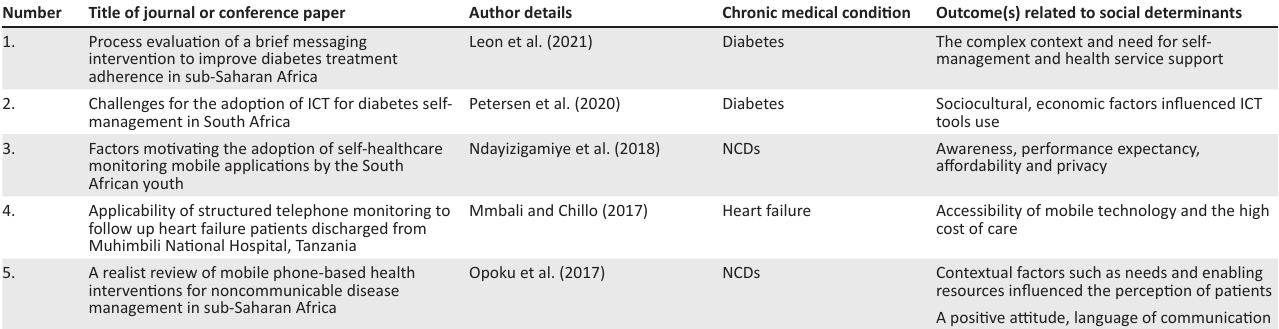
TABLE 4: Studies on social determinants of digital health use in self-management of chronic medical